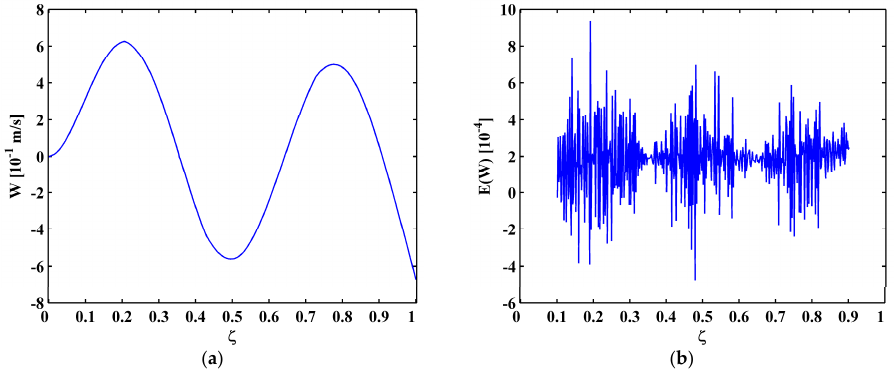
Figure 14. The fourth mode shape ( a ) and M-TKE ( b ) for Scenario I.